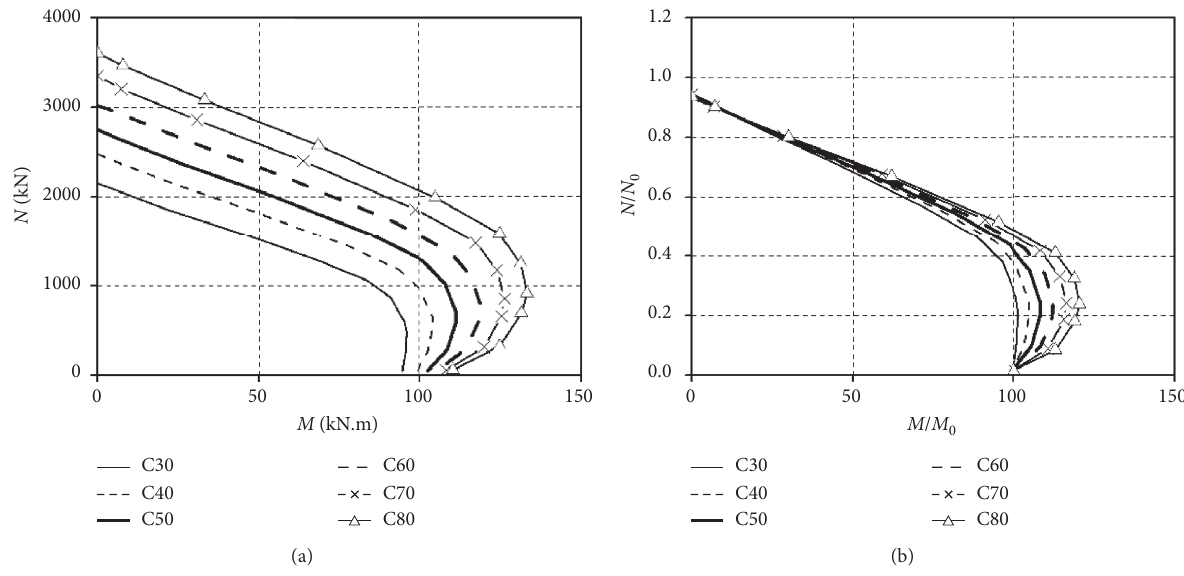
Figure 13: Influence of concrete strength ( f ) ck on component-based resistance correlation curves . (a) Slenderness ratio of 20. (b) Slenderness ratio of 20 (normalized).